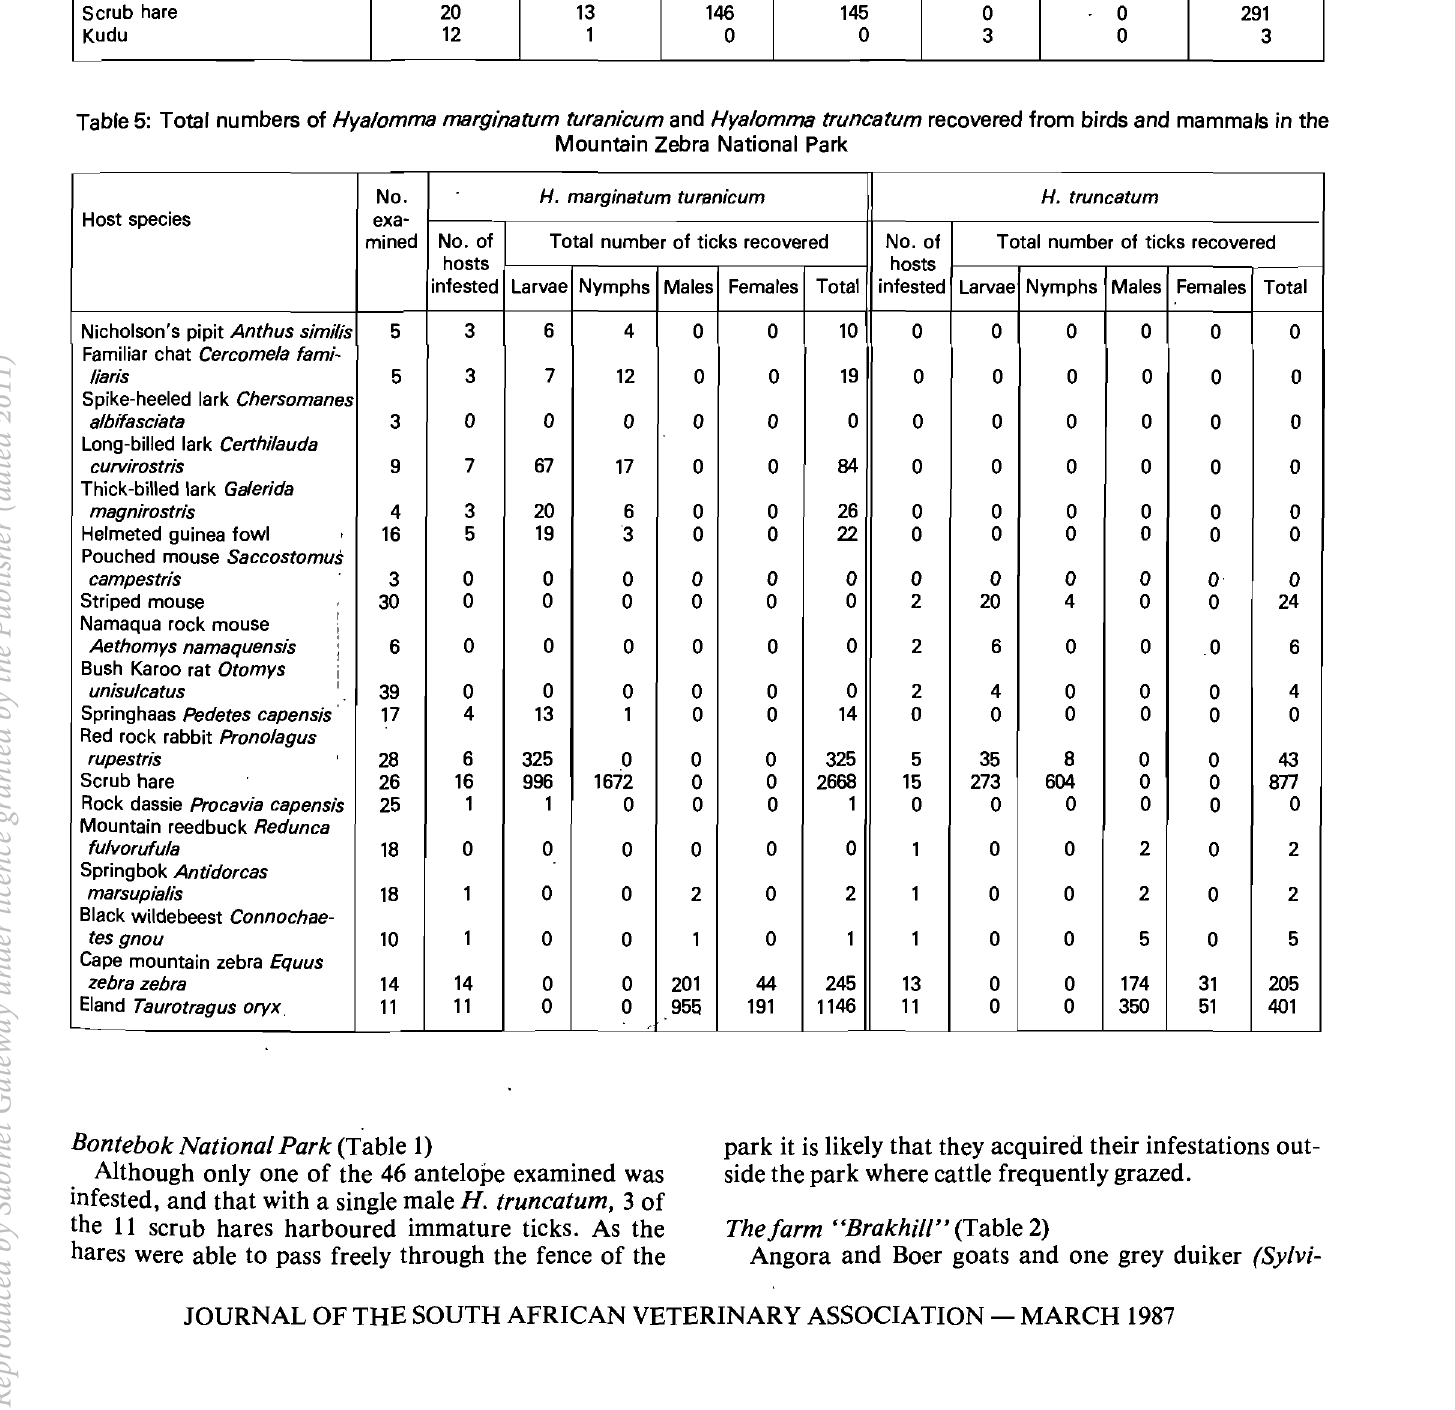
Table 4: Total numbers of Hyalomma mar gina tum rufipes collected from helmeted guinea fowl, scrub hare and kudu in the Andries Vos/oo Kudu Reserve No No Total number of ticks recovered Host species examined infested Helmeted guinea fowl